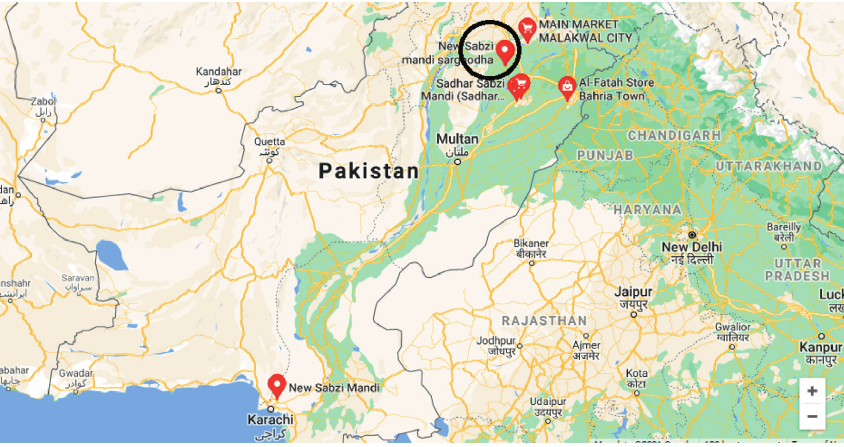
Figure 1: The geographic location of procurement of guava Table 1: Edible coating formulations from fenugreek galactomannan and guar galactomannan through central composite design. Treatments Fenugreek galactomannan (g/100ml) Guar galactomannan (g/100ml) Olive oil (ml/100 ml)